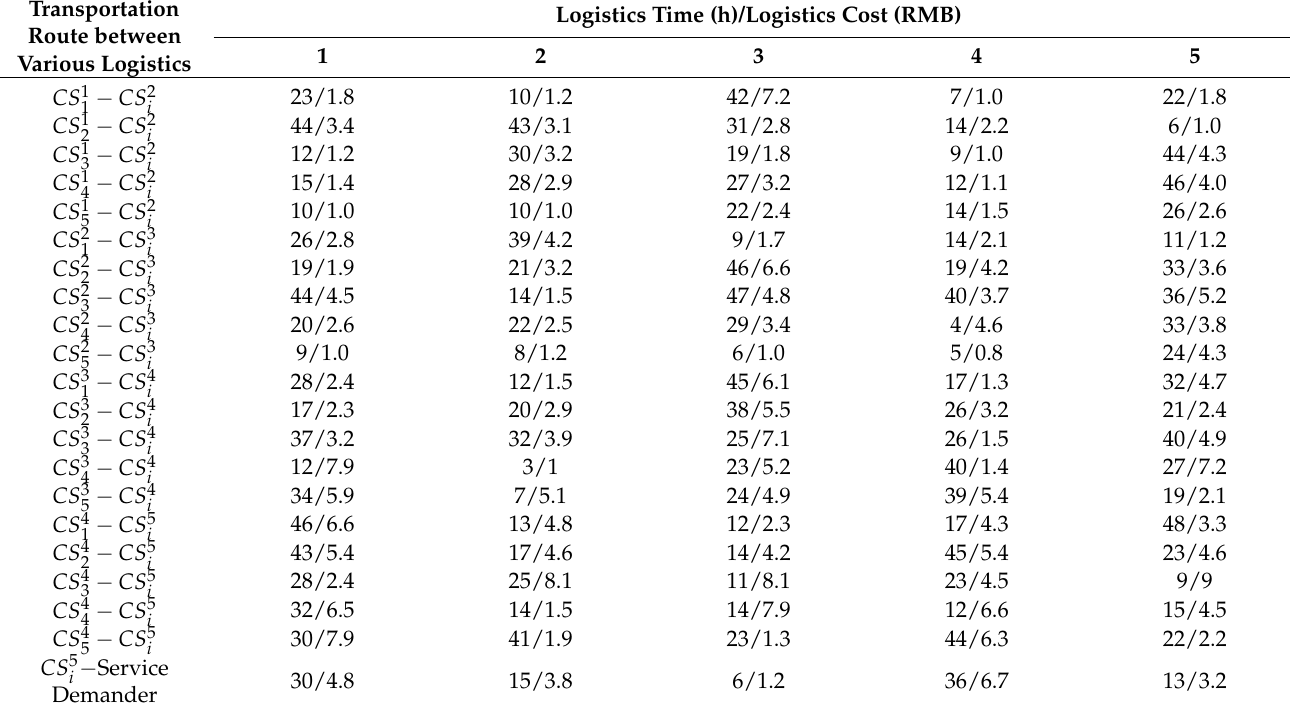
Table 5. The logistics time and logistics cost between the candidate outsourcing service providers.